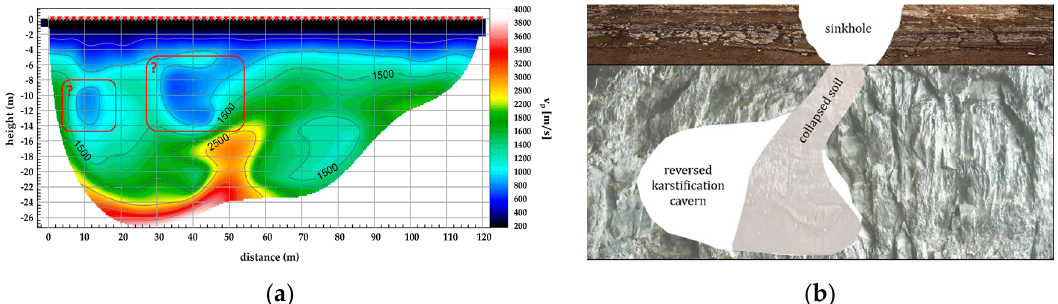
Figure 3. A sinkhole on Rijeka-Zagreb highway: ( a ) seismic refraction profile and ( b ) a collapse scheme.